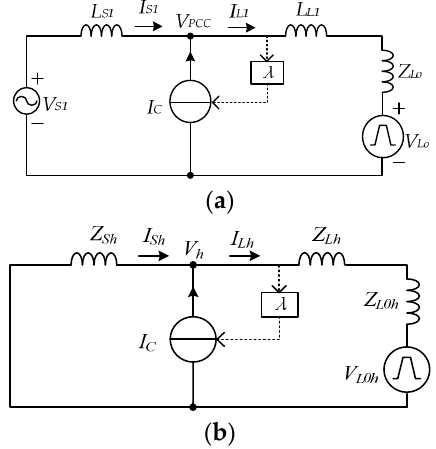
Figure 5. Single-phase equivalent circuit of parallel compensation voltage source type nonlinear load. ( a ) Single-phase fundamental equivalent circuit. ( b ) Single-phase harmonic equivalent